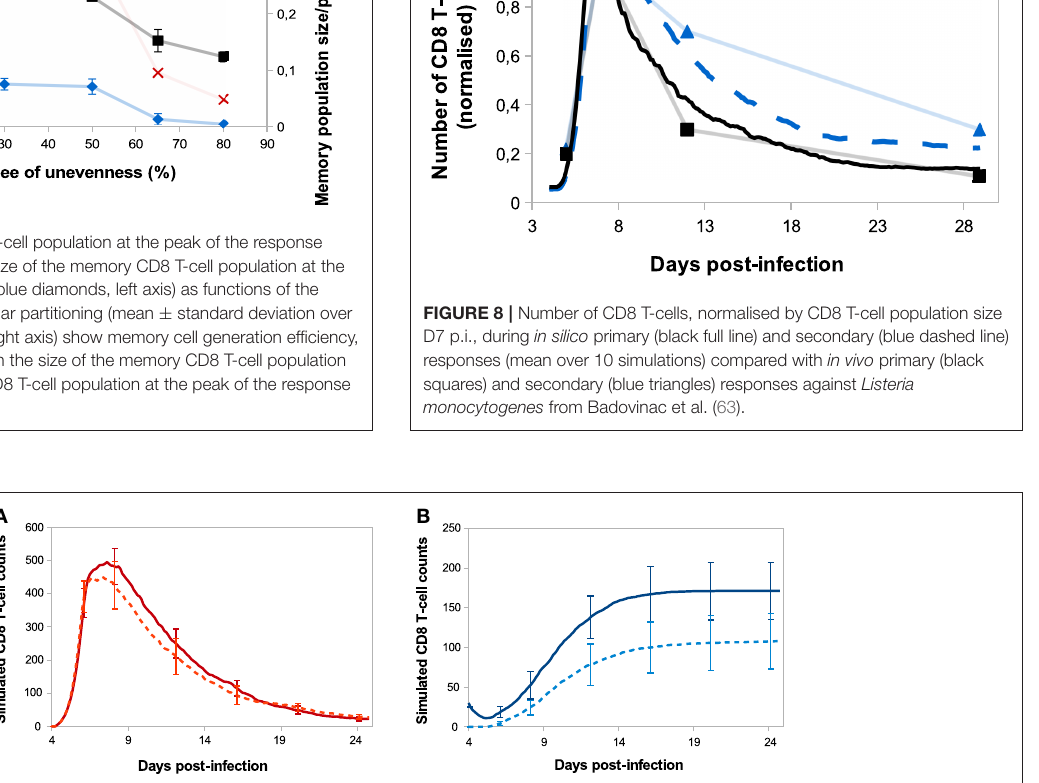
Frontiers in Immunology |